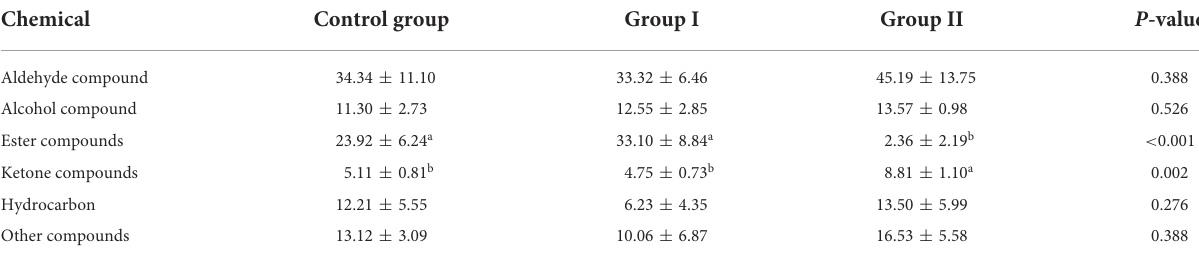
TABLE 11 Effects of dietary protein level on the relative amount of volatile compounds in the muscle of finishing pigs (%).